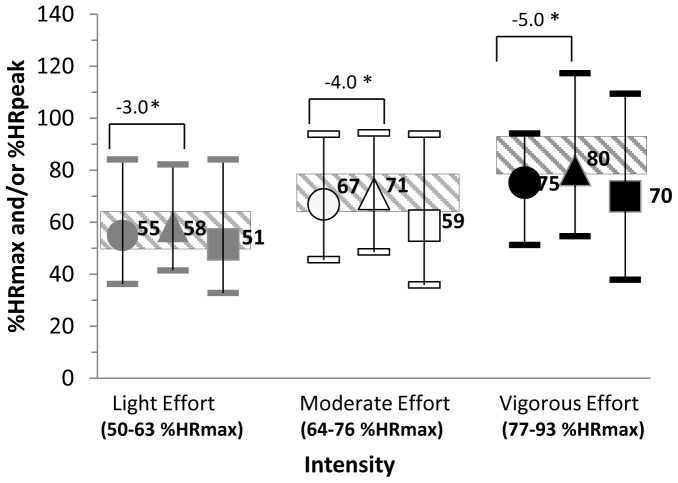
Measured %HRmax (n = 129) and %HRpeak (n = 35) during Light, Moderate and Vigorous Effort Treadmill exercise.* Significant difference at P<0.0001. •%HRmax = Observed HR/(220-age) (sub-sample, n = 35). ▴%HRpeak = Observed HR/(HRpeak VO2 treadmill test) (sub-sample, n = 35). ▪%HRmax = Observed HR/(220-age) (population, n = 129). Cross-hatched boxes = %HRmax range: 50–63% light effort; 64–76% moderate effort; 77–93% vigorous effort.